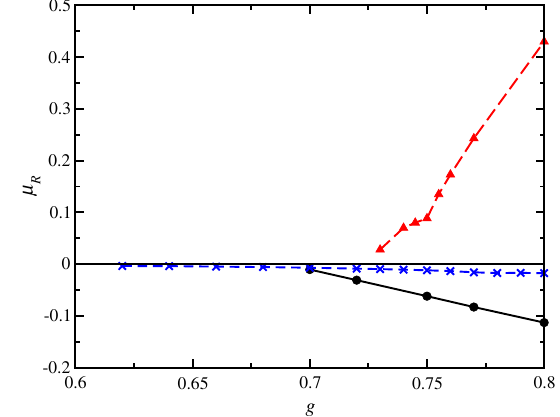
FIG. 2. Stability diagram of the asynchronous state. The real part of the discrete eigenvalues is reported versus the coupling strength g .